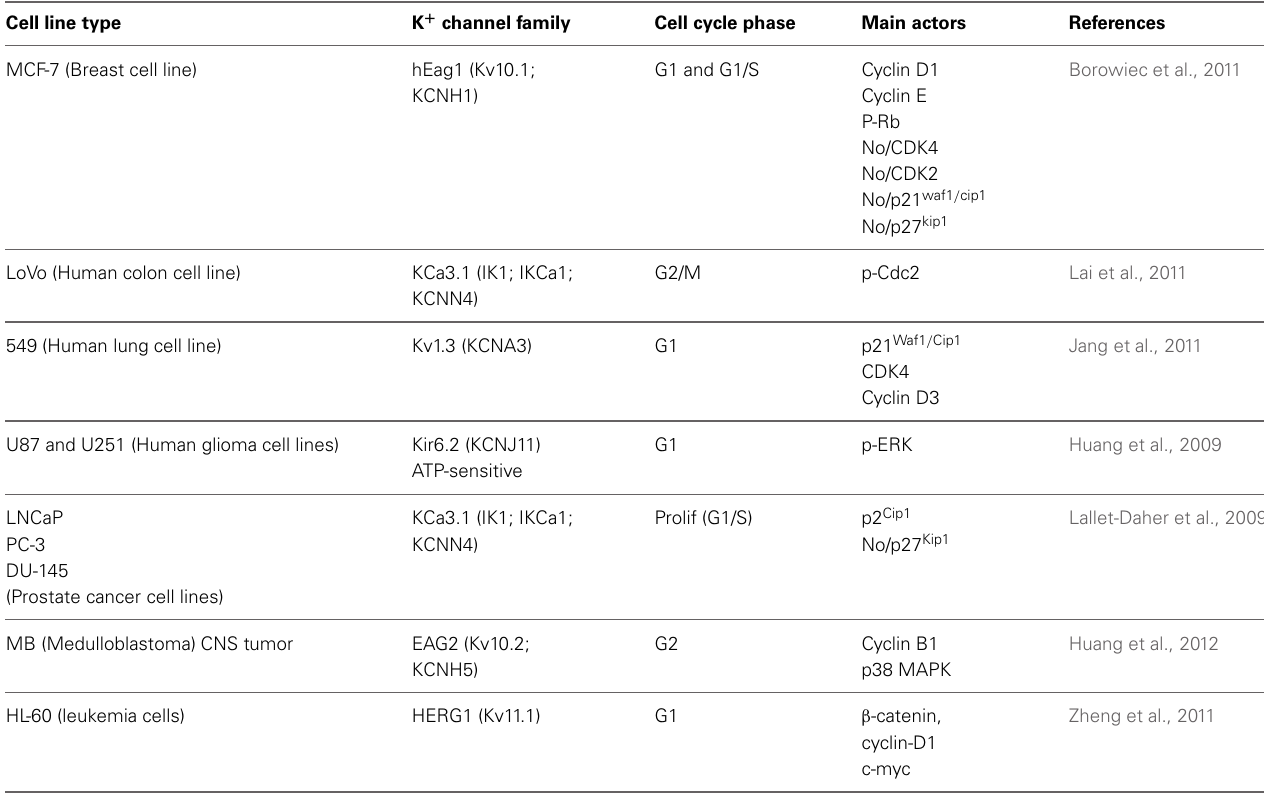
Table 1 | K + channels and cell cycle protein actors in